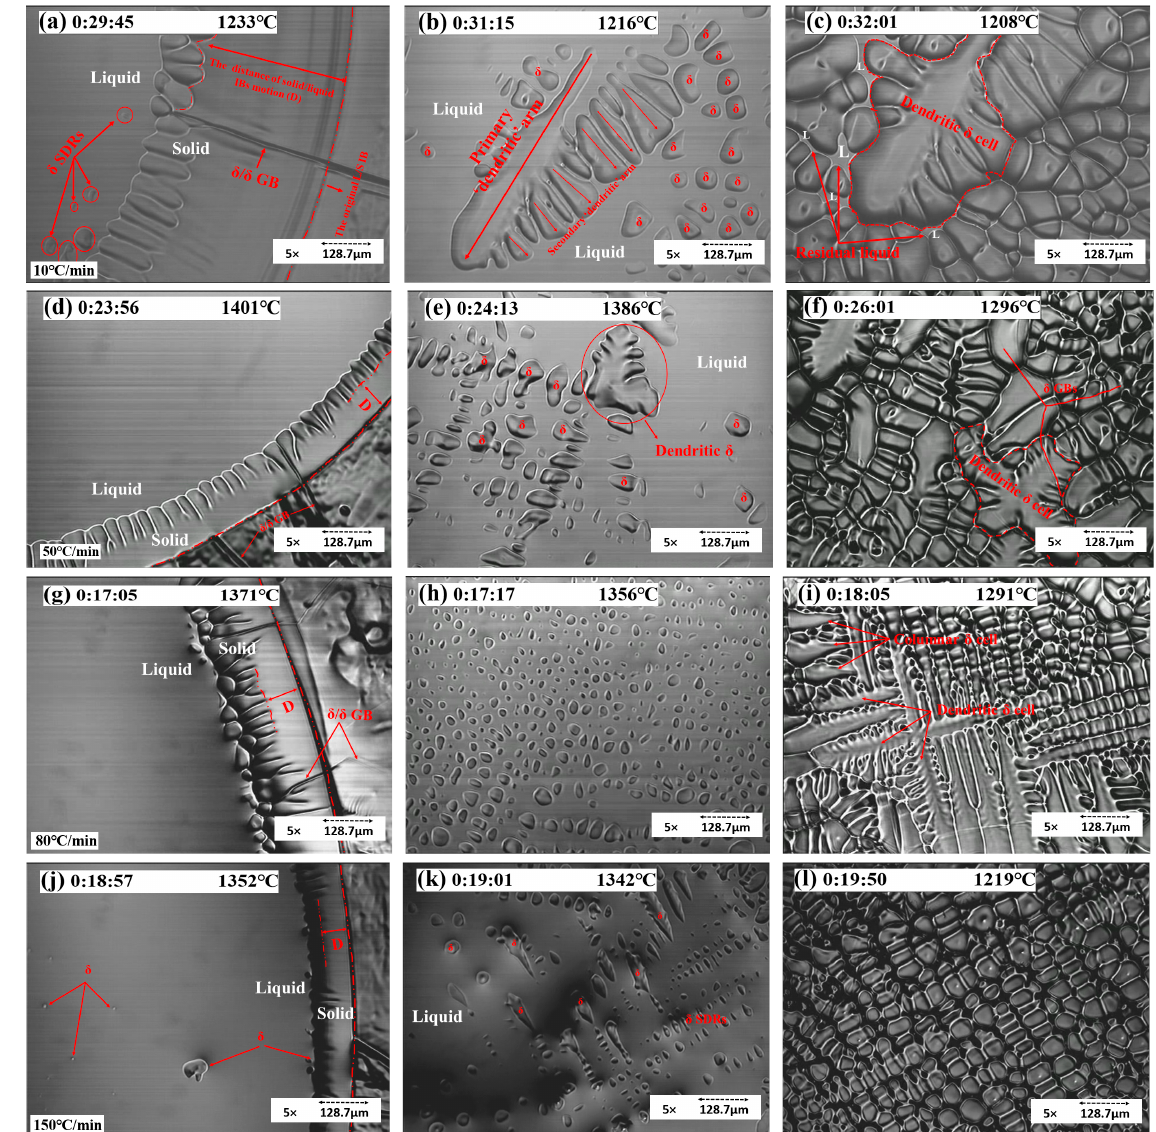
Figure 9. Concentric HTCM revealing the solidification process of S32101 under the cooling rates of ( a – c ) 10 °C/min ( d – f ) 50 °C/min ( g – i ) 80 °C/min, and ( j – l ) 150 °C/min.